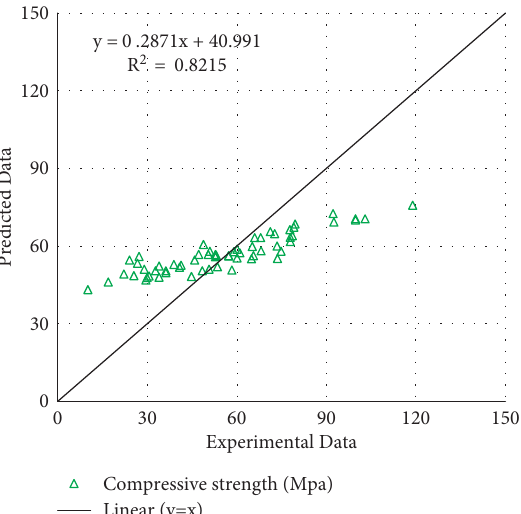
Figure 11: Compressive strength experimental versus predicted values for the ANN-GA (7-13) model using testing data.